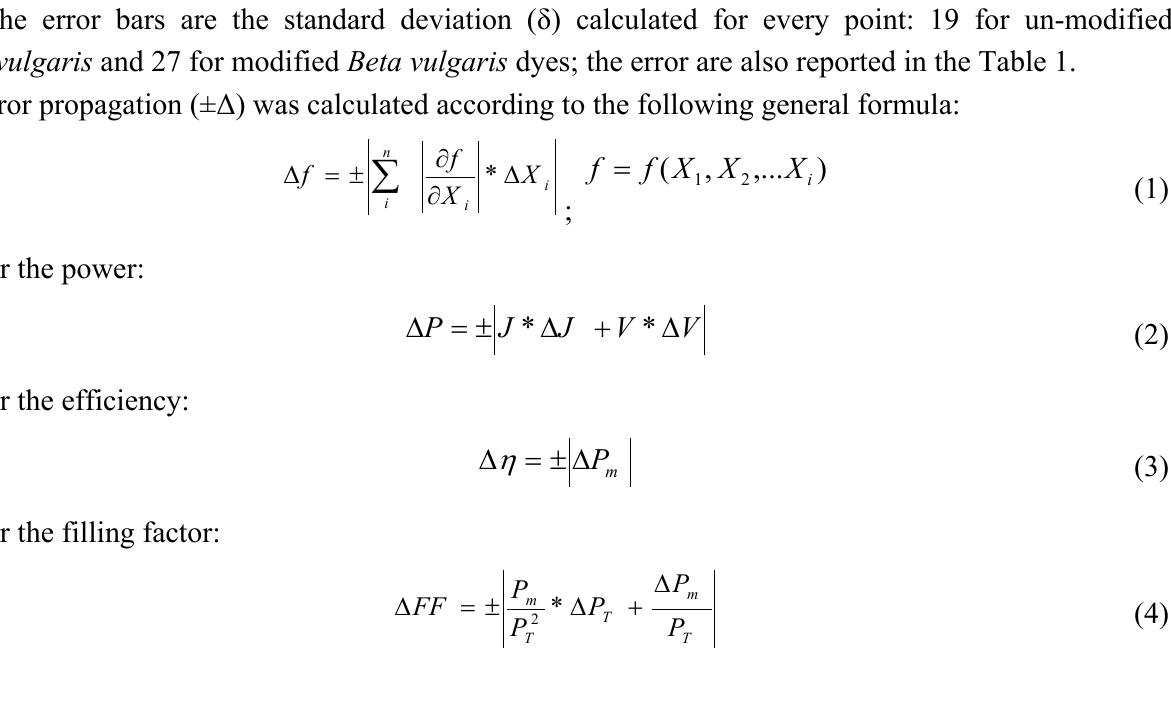
Figure 3. SEM images of ( a ) TiO ( b ) the second nanoporous TiO